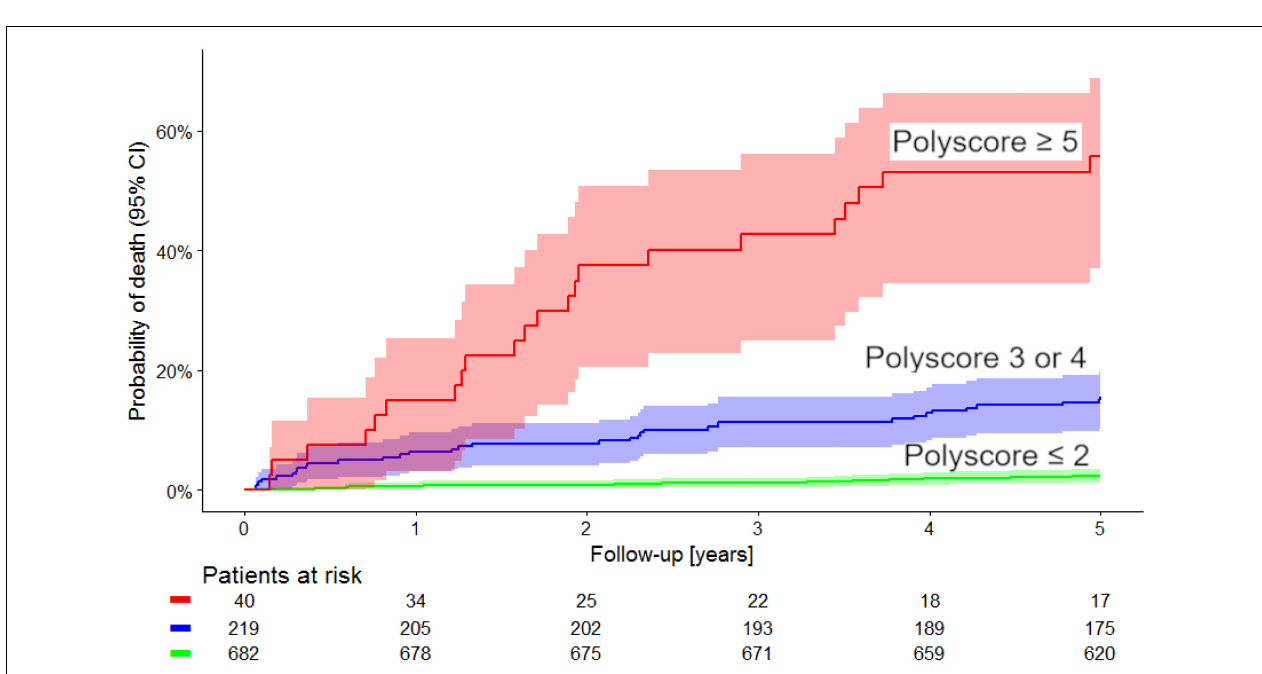
FIGURE 4 | Comparison of Kaplan–Meier probabilities of death in the population sub-groups defined by Polyscore ≤ 2 (green), Polyscore 3 or 4 (blue) and Polyscore ≥ 5 (red). Albeit positively biased (see the text for details) the difference between the probabilities of death in these groups was statistically significant ( p < 0.0001, χ 2 = 220). Numbers of patients at risk in the individual sub-groups are shown below the time axis.